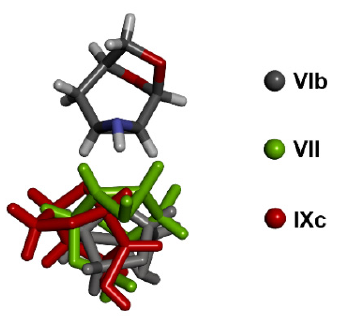
Figure 10. Different orientations of adjacent molecules utilizing hydrogen bonding of NH towards pyranose oxygen O1 in structures VI (gray), VII (green) and IX (red).